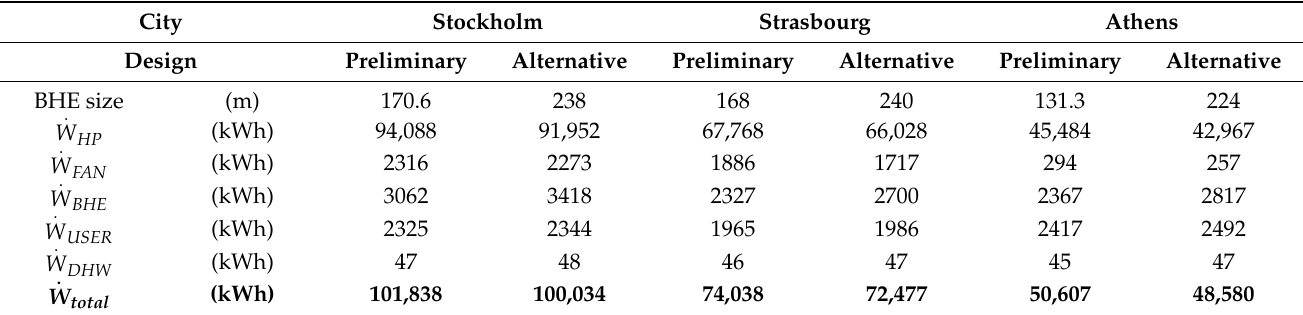
Table 7. Electrical consumption of the HP components during 25 years of operation (in kWh).